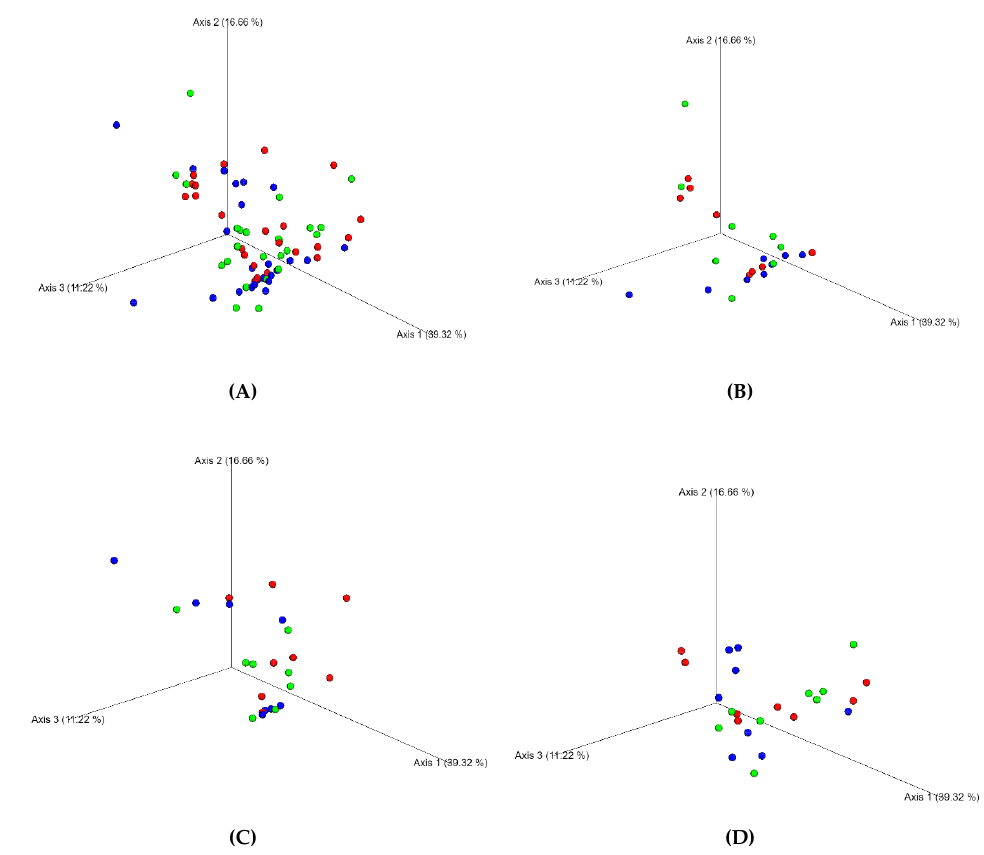
Figure 2. Principal coordinate analysis (PCoA) plot representing the beta diversity of the microbial community between dietary treatments with increasing dose of grape proanthocyanidins (D0, D1, and D3). PCoA was calculated on the weighted UniFrac distance matrices. (A) Beta diversity for the three dietary treatments and the three times of sampling; (B) beta diversity for the three dietary treatments and at the beginning of the study (T0); (C) beta diversity for the three dietary treatments after 14 days (T14); and (D) beta diversity for the three dietary treatments after 14 days (T14).